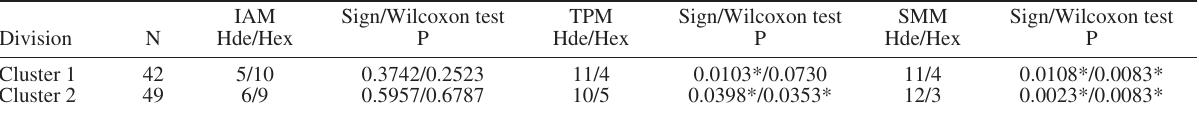
Table 3. – Results from the POWSIM tests for 15 microsatellite loci studied in C. undecimalis divided into the two clusters (1 and 2) identi- fied using STRUCTURE. Four levels of population differentiation (F N =500 and N =1000, and the simulation was replicated 1000 times. Proportion of significance (P<0.05) for Fisher’s exact P values are shown. e e Sample sizes after complete drift process